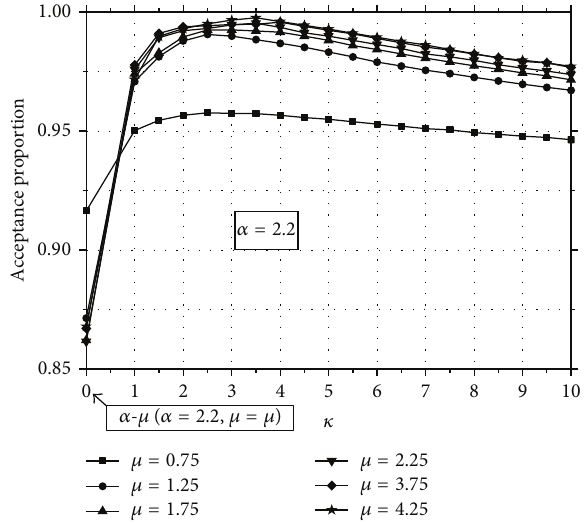
Figure 4: Rejection method efficiency for the 𝛼 - 𝜅 - 𝜇 distribution with 𝛼 = 2.2 .